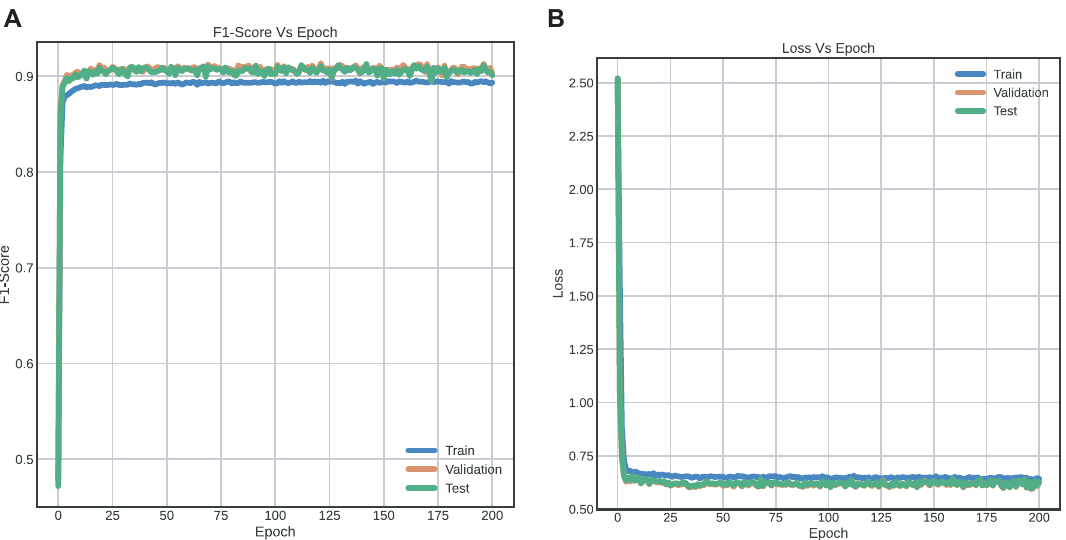
Figure 7: Training curves with FNN implemented for binary classification (two-label dataset) (A) F1-score vs epochs (B) Loss vs epochs.